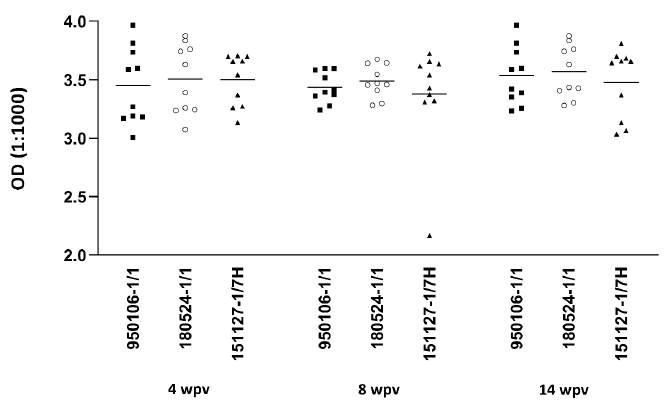
Figure 3. Trout plasma antibody cross-reactivity. ELISA was performed using plasma (1:1000) of vaccinated fish (vaccinated with formalin-killed whole cells of F. psychrophilum strain 950106-1/1 adjuvanted with Freund’s Incomplete Adjuvant) and measured at 4, 8 and 14 weeks post-vaccination (wpv). Reactivity was measured towards three different F. psychrophilum strains: 950106-1/1 (serotype Fd), 180524-1/1 (serotype Th) and 151127-1/7H (serotype Th). O.D. values were compared using Kruskal–Wallis test with Dunn’s multiple comparison test. p < 0.05. Reactions did not differ between serotypes, indicating high cross-reaction between strains.